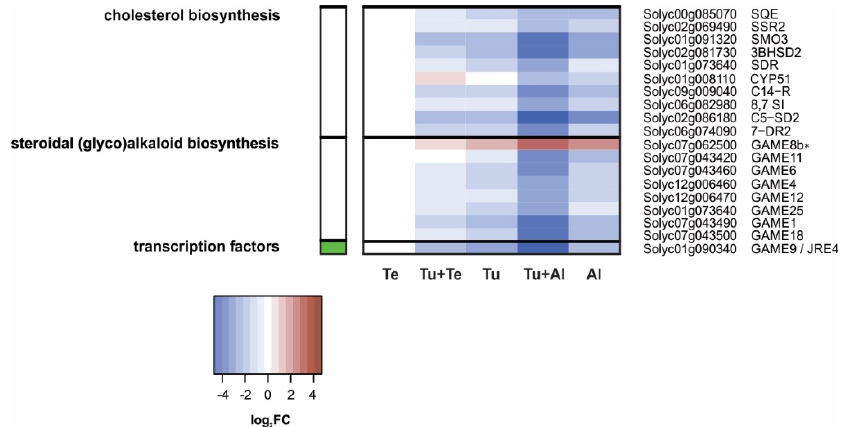
Figure 7. Gene-expression heat map depicting the relative transcript levels of tomato ( Solanum lycopersicum ) genes that encode proteins with a (predicted) function in cholesterol and steroidal (glyco)alkaloid biosynthesis and that were differentially expressed in leaves after seven days of infestation with herbivorous mites. Tomato leaves were infested with either a single mite species ( Tetranychus urticae (Tu), Tetranychus evansi (Te), or Aculops lycopersici (Al)) or two species simultaneously ( T. urticae plus T. evansi (Tu+Te), or T. urticae plus A. lycopersici (Tu+Al)). Non-infested plants served as controls and were used as a common reference in the transcriptional comparisons. Presented genes were differentially expressed (Benjamini and Hochberg false discovery rate adjusted p ≤ 0.05; Log 2 fold change (FC) ≥ 0.585) in at least one of the mite-infestation treatments. The different (sub)sections of the pathway are specified on the left. The light green square in the leftmost column denotes JA-inducibility of the respective gene according to [114]. The asterisk indicates that the enzyme encoded by this GAME gene has not been characterized in tomato, i.e., only in potato [115].